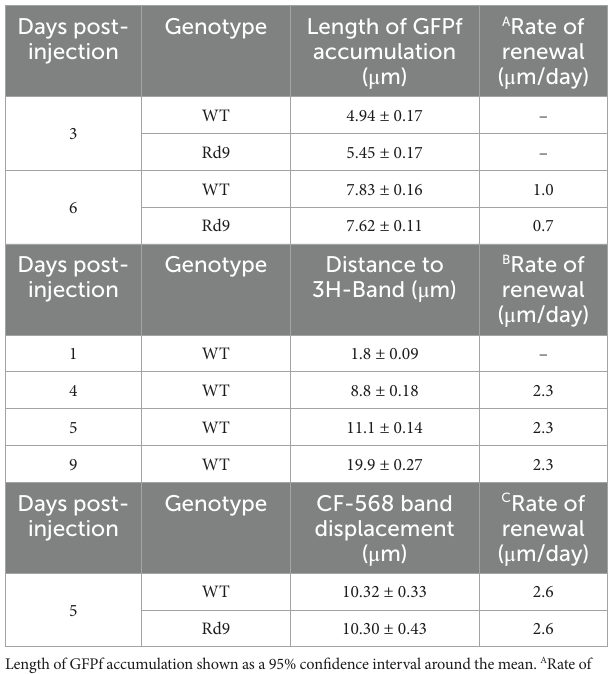
TABLE 1 Summary table of outer segment growth measurements compared to historical